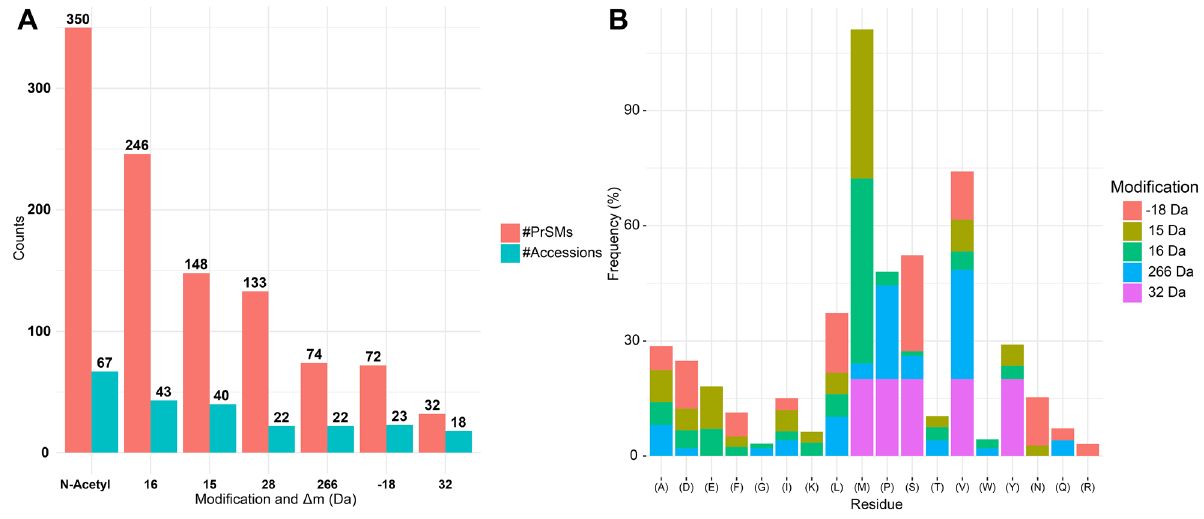
Figure 2. Number of identified PrSMs and protein accessions of the most frequent modifications and ratio of unambiguously identified residues of each mass shift. ( A ) Number of proteoform spectrum matches (PrSMs) and proteins identified with most frequent mass shifts and N-terminal acetylation. ( B ) Ratio of the number PrSMs of an amino acid residue modified by each mass shifts (Δm) and the total PrSMs identified with the same Δm. For example, the number of methionine identified with mass shift of 16 Da (41 PrSMs)/number of all residues identified with 16 Da Δm (85 PrSMs) = 48% (represented by the light green bar above the (M) in the x